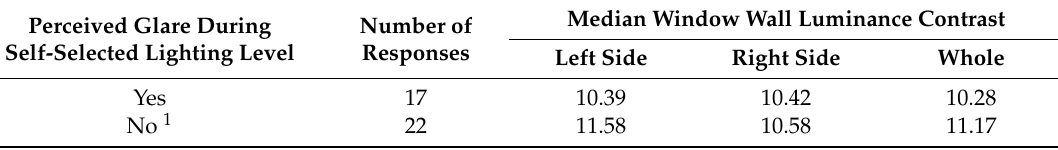
Table 5. Average median luminance contrast and participants’ responses for perceived discomfort glare from the window during stage